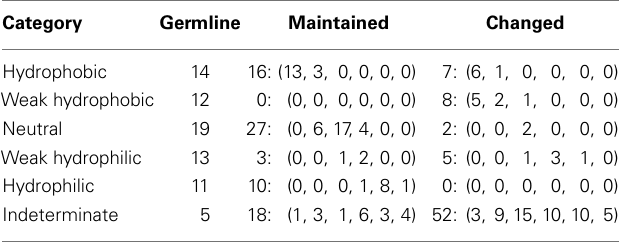
Table 1 | Number of positions for each amino acid usage